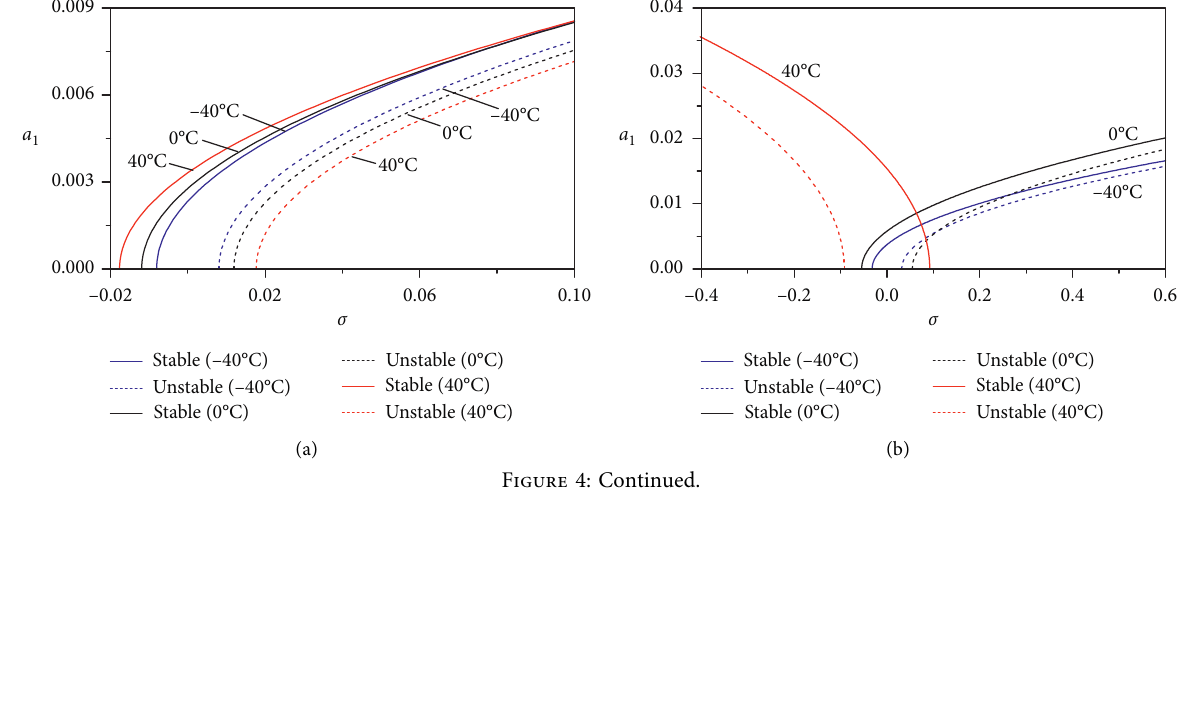
and response amplitude a 21